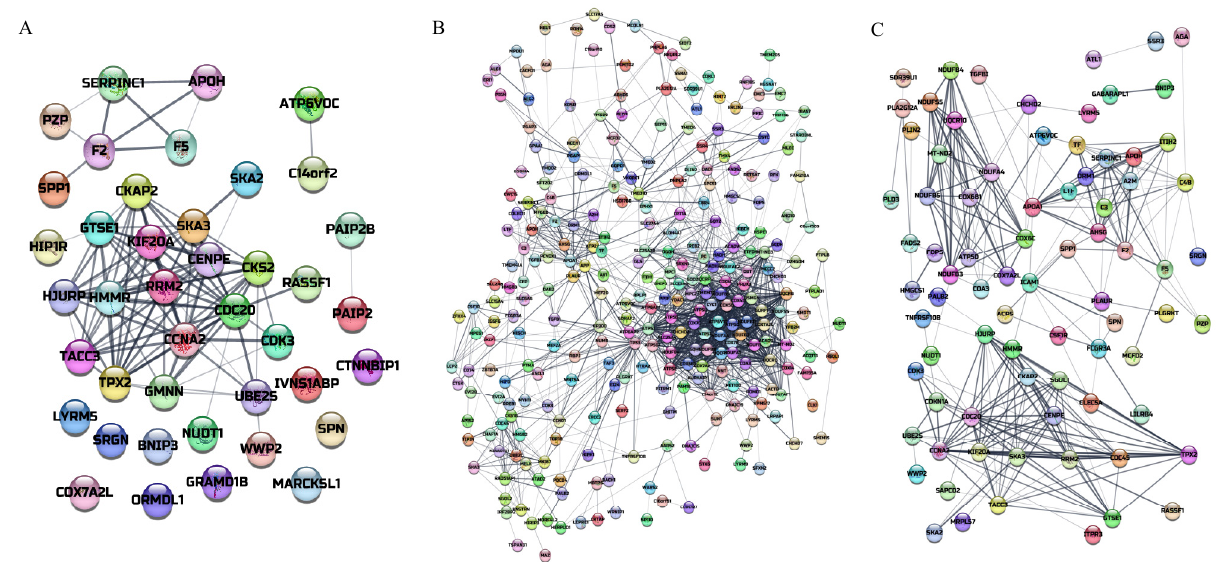
Figure 6. A protein interaction network diagram of differentially expressed proteins of macrophages treated with acetaminophen (APAP) in the presence or absence of polydatin (HU). ( A ) APAP100 vs. control group, ( B ) APAP500 vs. control group, and ( C ) APAP500-HU vs. control group.